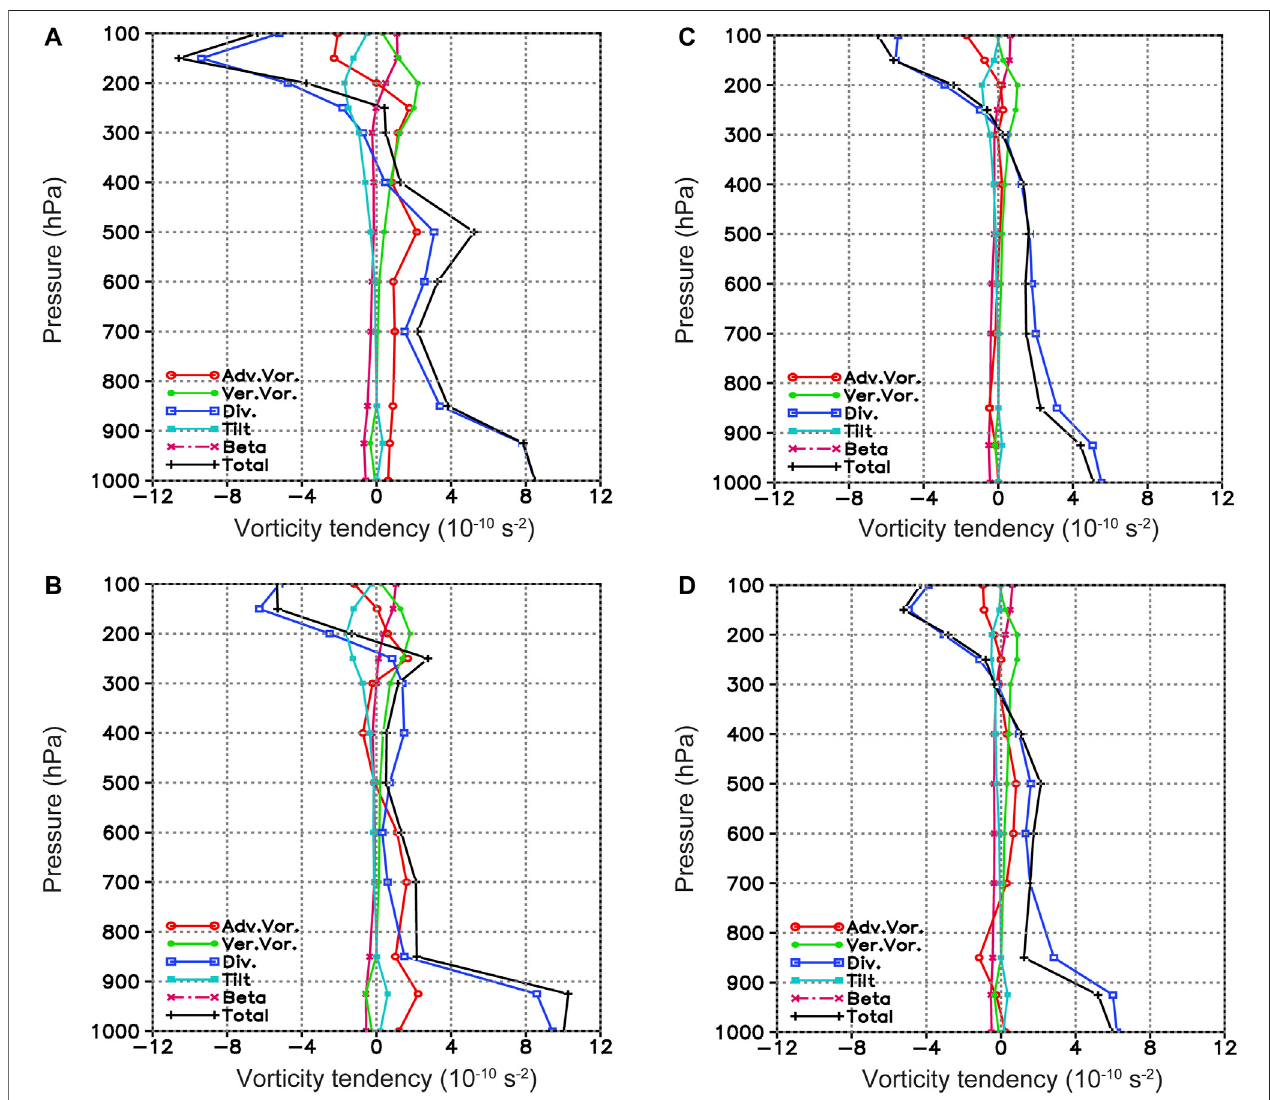
FIGURE 9 | Vertical distribution of the regional average vorticity budget (units: 10 – 10 s − 2 ) in the 5 ° area near the center of the composited (A, B) ERLTC and (C, D) NERLTC 1 day before (A, C) and on the day (B, D) of the extreme or non-extreme rainfall.